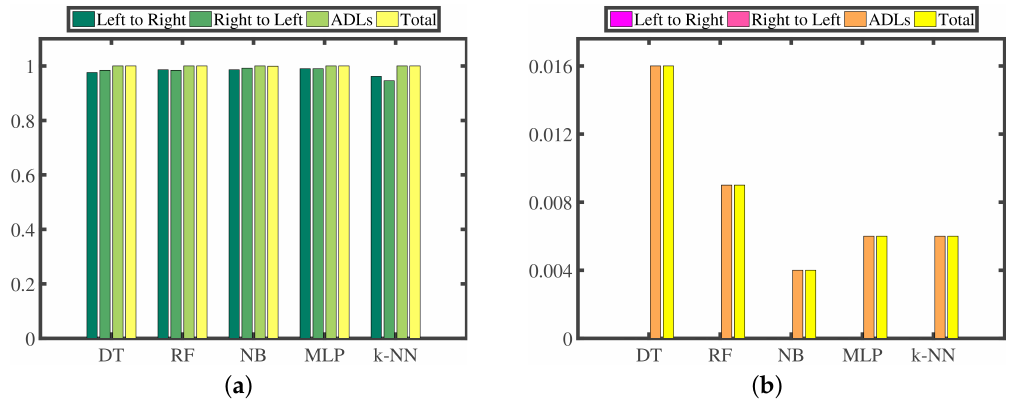
Figure 21. True positive rate (TPR) ( a ) and false positive rate (FPR) ( b ) of different recognition